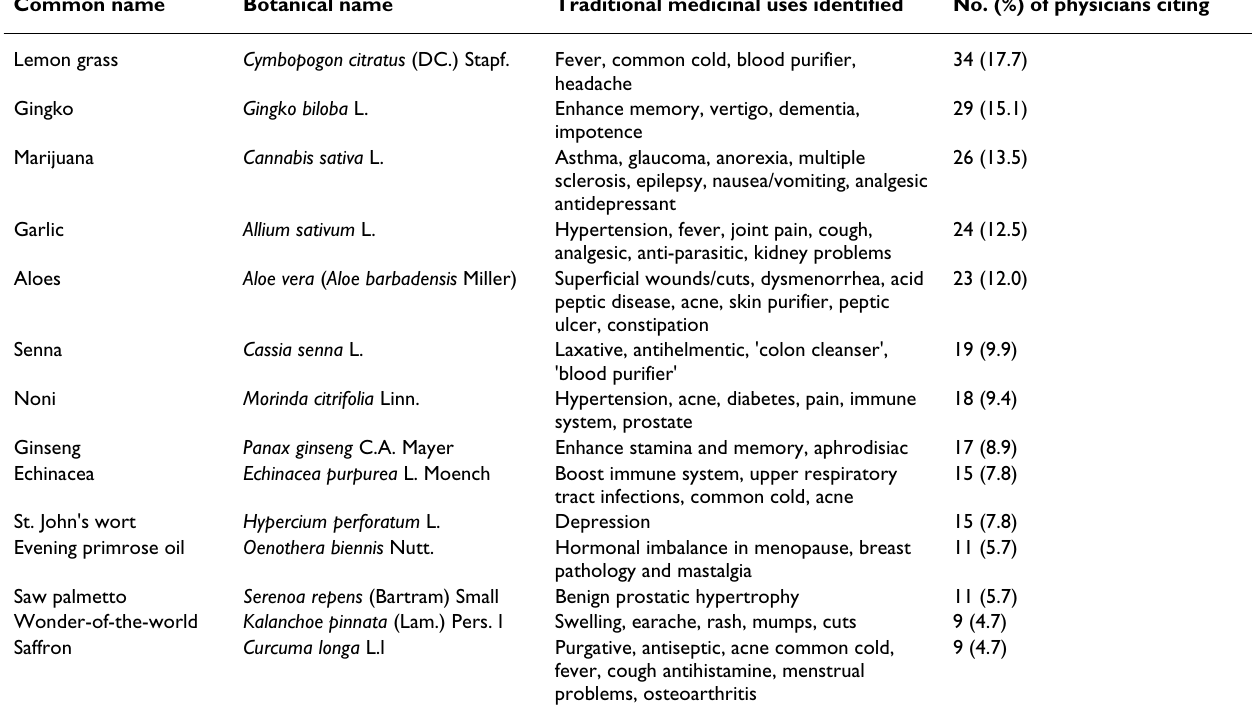
Table 2: Most common medicinal herbs and their reputed uses cited by public health sector physicians in Trinidad Common name Botanical name Traditional medicinal uses identified No. (%) of physicians